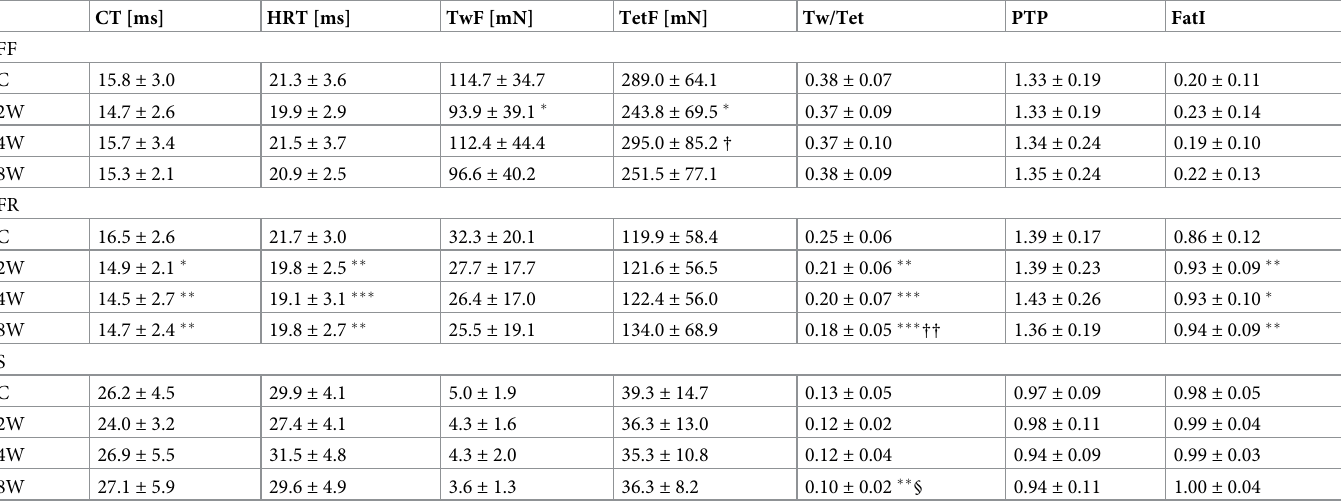
Table 1. Contractile properties of the studied motor units in control and trained animals.